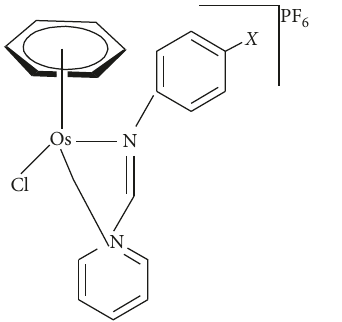
Figure 8: Molecular structure of [( s 6 -benzene)OsCl(C CH � N-C 6 H 5 X )] (where X � p-F(1), p -Cl(2), p -CH 3 (PF 6 )).